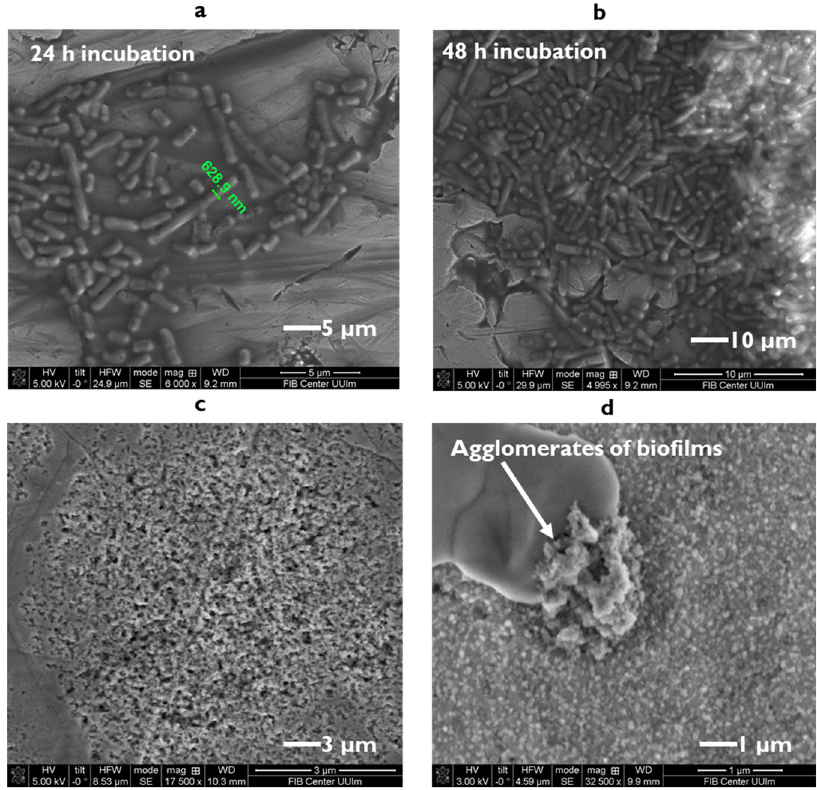
Fig. 10 Scanning electron microscopy images of L. parabuchneri DSM 5987 bio fi lms grown at stainless steel surfaces. Bio fi lm-forming L. parabuchneri cells: a after 24 h of incubation; b after 48 h of incubation; c after 72 h of incubation, and d by exemplary agglomerates embedded into EPS and adherent to the surface. 1 – 10 μ m scale bars are shown on